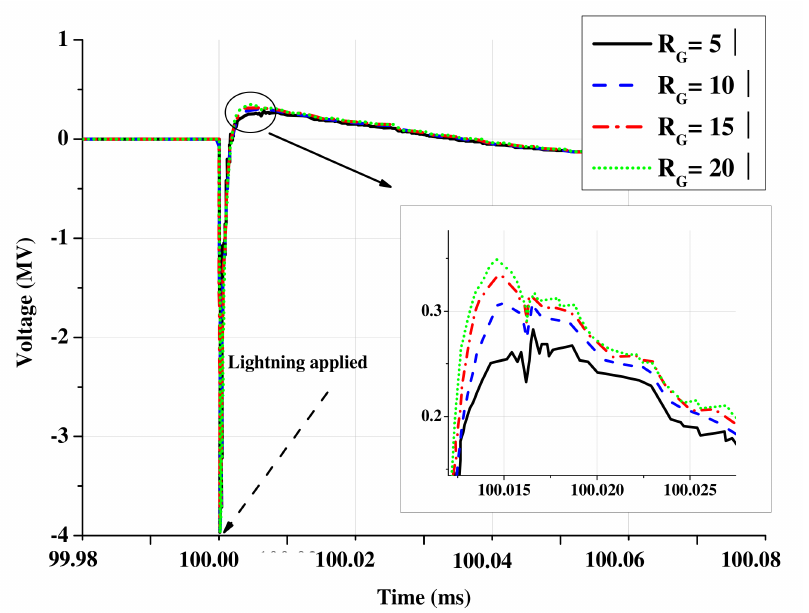
Figure 16. Voltage of the shielding wire at the strike point with changing tower grounding